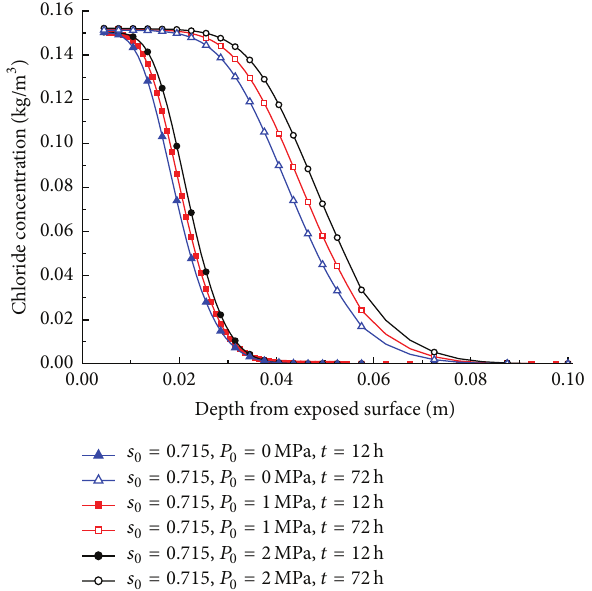
Figure 11: Chloride concentration simulation under different hydraulic